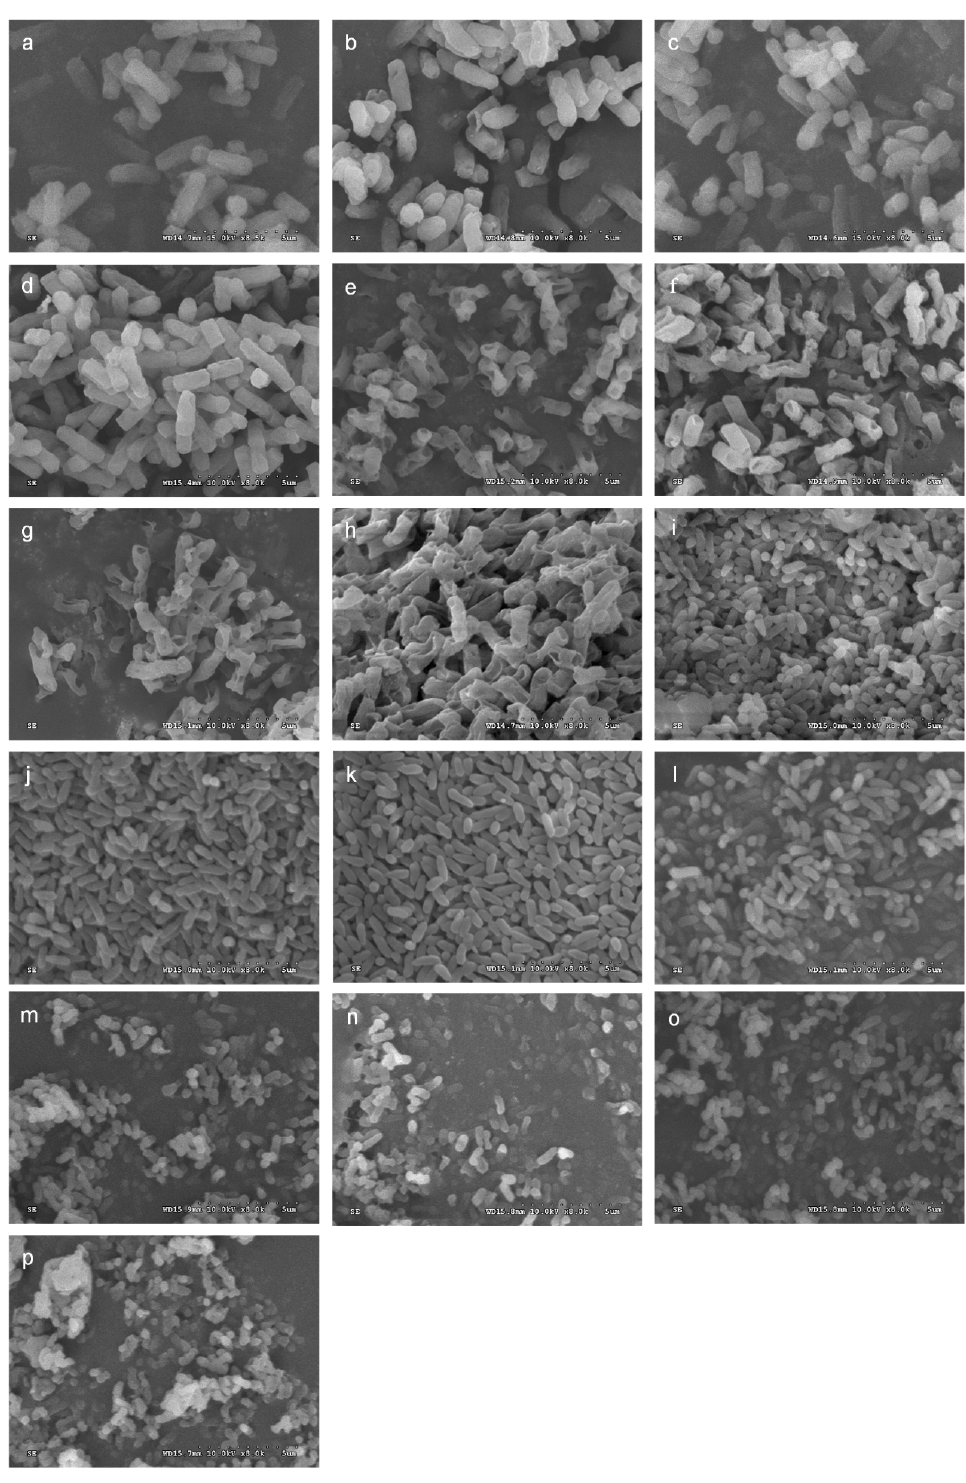
Figure 4. Scanning electron microphotographs of B. thermosphacta and P. fluorescens . B. thermosphacta untreated for 4 h ( a ), untreated for 8 h ( b ), treated with 2% ethanol for 4 h ( c ), treated with 2% ethanol for 8 h ( d ), treated with 3-carene at 1 × MIC for 4 h ( e ), treated with 3-carene at 1 × MIC for 8 h ( f ), treated with 3-carene at 2 × MIC for 4 h ( g ), treated with 3-carene at 2 × MIC for 8 h ( h ); P. fluorescens untreated for 4 h ( i ), untreated for 8 h ( j ), treated with 2% ethanol for 4 h ( k ), treated with 2% ethanol for 8 h ( l ), treated with 3-carene at 1 × MIC for 4 h ( m ), treated with 3-carene at 1 × MIC for 8 h ( n ), treated with 3-carene at 2 × MIC for 4 h ( o ), treated with 3-carene at 2 × MIC for 8 h ( p